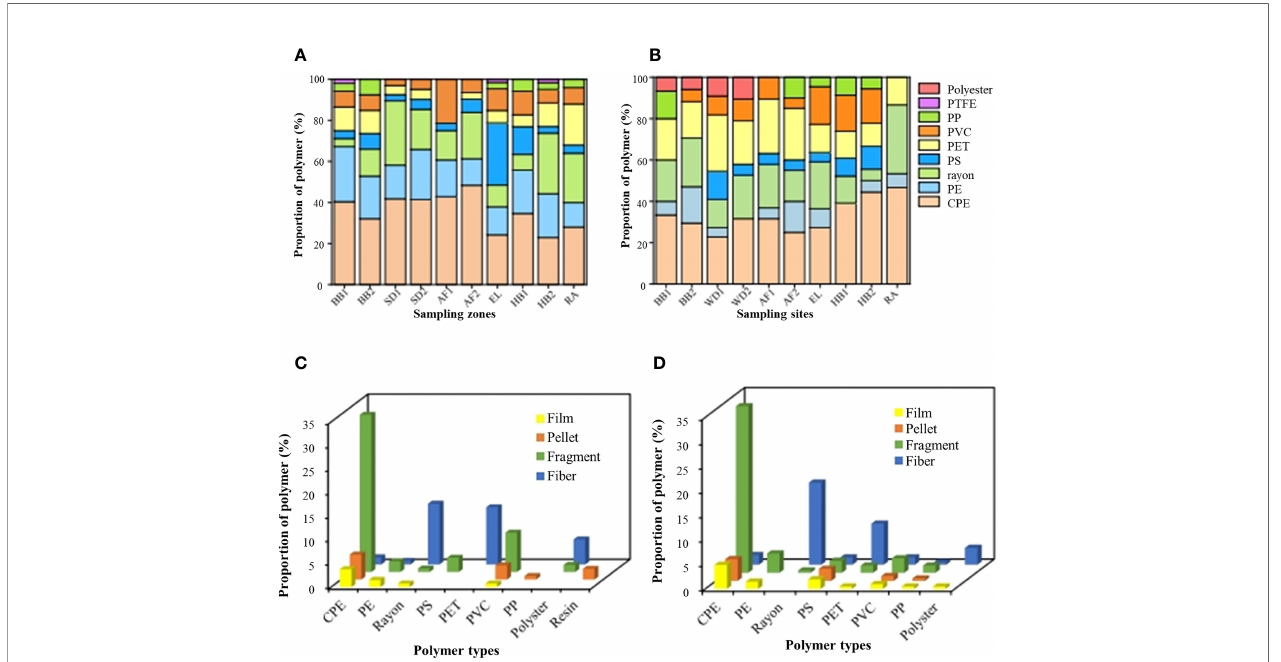
FIGURE 5 | The polymer composition of MPs in the seawater (A) and sediment samples (B) collected from each sampling zone. Relative proportion of MPs classi fi ed by the morphological types in the BB1 (C) and BB2 (D) . PE, polyethylene; CPE, chlorinated polyethylene; PP, polypropylene; PS, polystyrene; PET, polyethylene terephthalate; PVC, polyvinyl chloride and PTFE, poly tetra fl